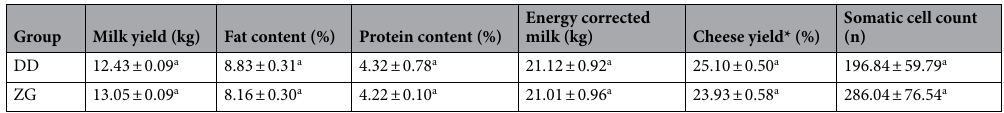
Table 1. Average milk yield and milk quality traits in buffaloes of zero grazing (ZG) and dry diet (DD) Group. Data regarding energy corrected milk (ECM), cheese yield and somatic cell count were also reported. Data